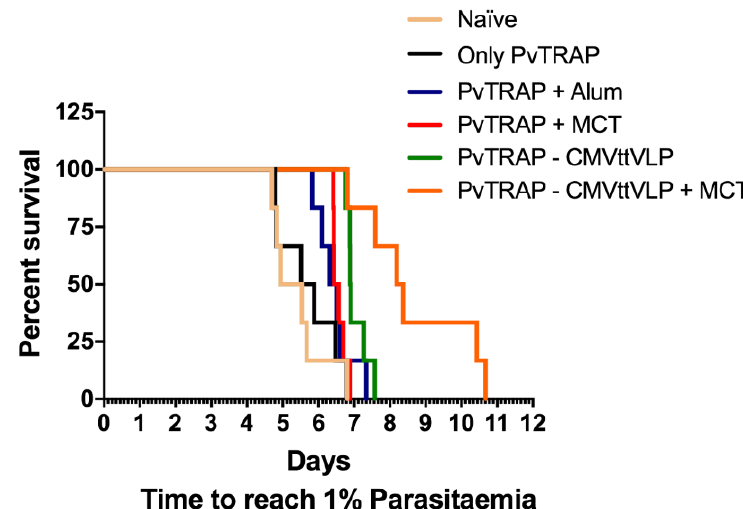
Figure 7. Survival curve of challenge with P. berghei expressing TRAP P . vivax . As previously described, the mice were challenged on Day 42 and the parasitaemia was checked daily, beginning on fourth day after challenge until the mice reach 1% parasitaemia. Table 1. Statistical analysis results of the challenge with P. berghei expressing P. vivax TRAP . As shown in this table, all groups vaccinated with protein plus adjuvant and/or VLP show significantly increased survival compared to the group vaccinated with PBS (naïve). However, when we compare naïve vs. only protein, there is no statistical difference. When comparing mice vaccinated with only protein with protein plus alum adjuvants, there was no statistical difference in survival, but if those groups are compared with MCT and or VLP, there is a significant difference in survival. The group vaccinated with PvTRAP-CMVttVLP + MCT adjuvant exhibits significantly better protection compared with all other groups. Data of six mice per group were analysed using GraphPad Prism